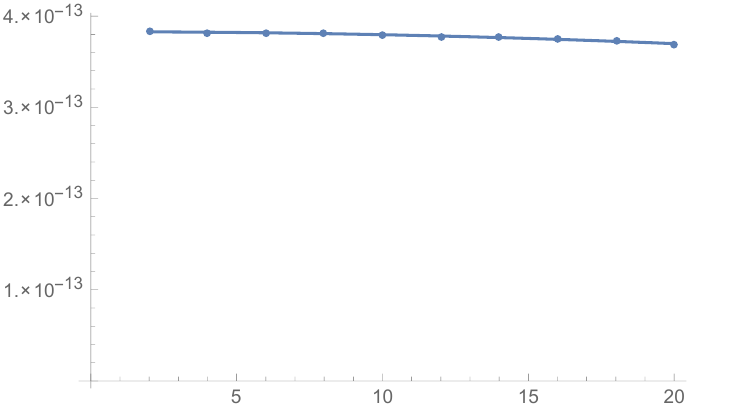
Figure 7. Fourier coefficients c m (in N) for cosines with even m = 2,4,6, . . . at z = 200 nm. The solid line is a best fit of the data by the curve c m = v 0 + v 2 m 2 .